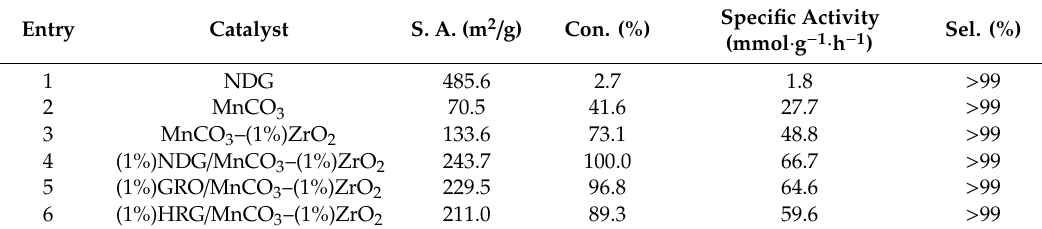
Table 1. Aerobic oxidation of PhCH 2 OH over various catalysts.